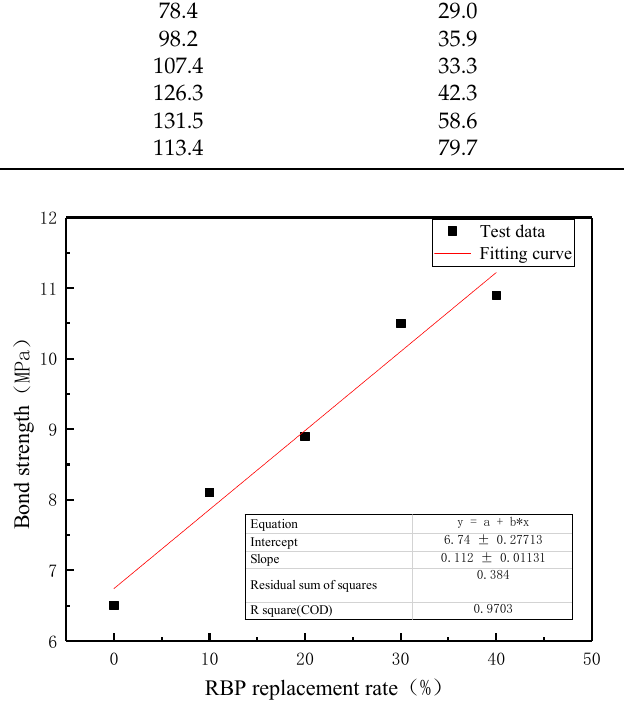
Figure 8. Relationship between brick powder substitution rate and bond strength.